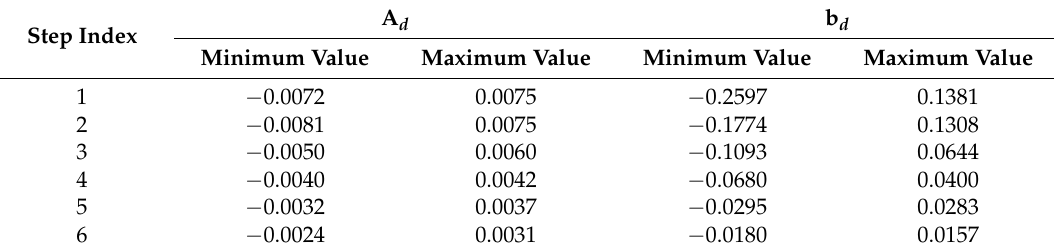
Table 1. Data ranges for a typical HoG-based 6-step